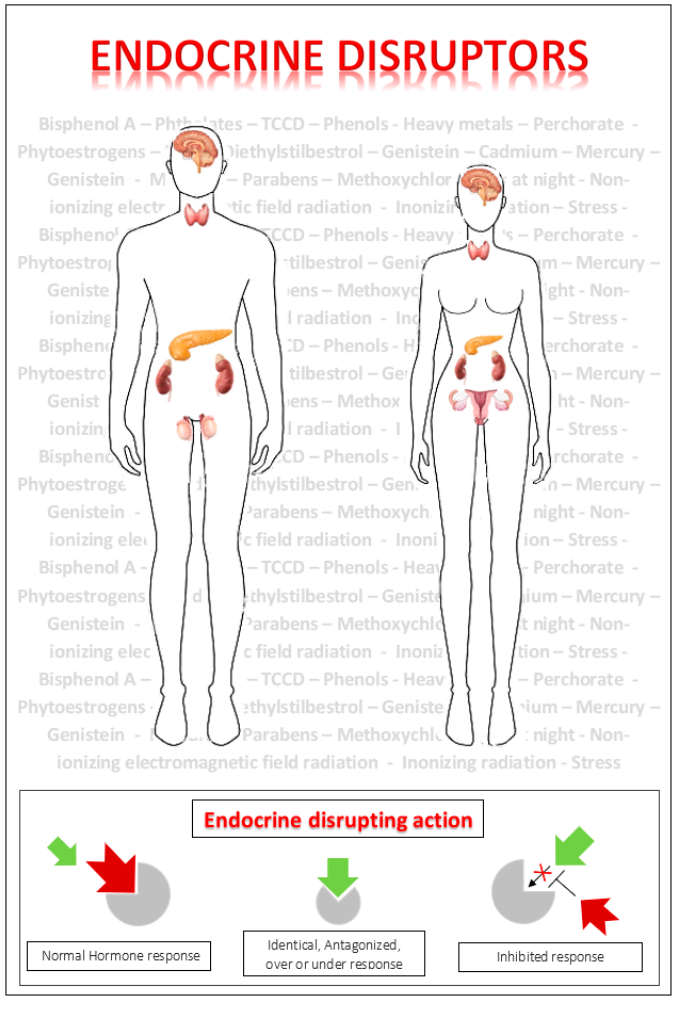
Figure 1. Chemical endocrine disruptors interfering with the endocrine system mimicking, antago- nizing, under- or over-stimulating hormonal response.